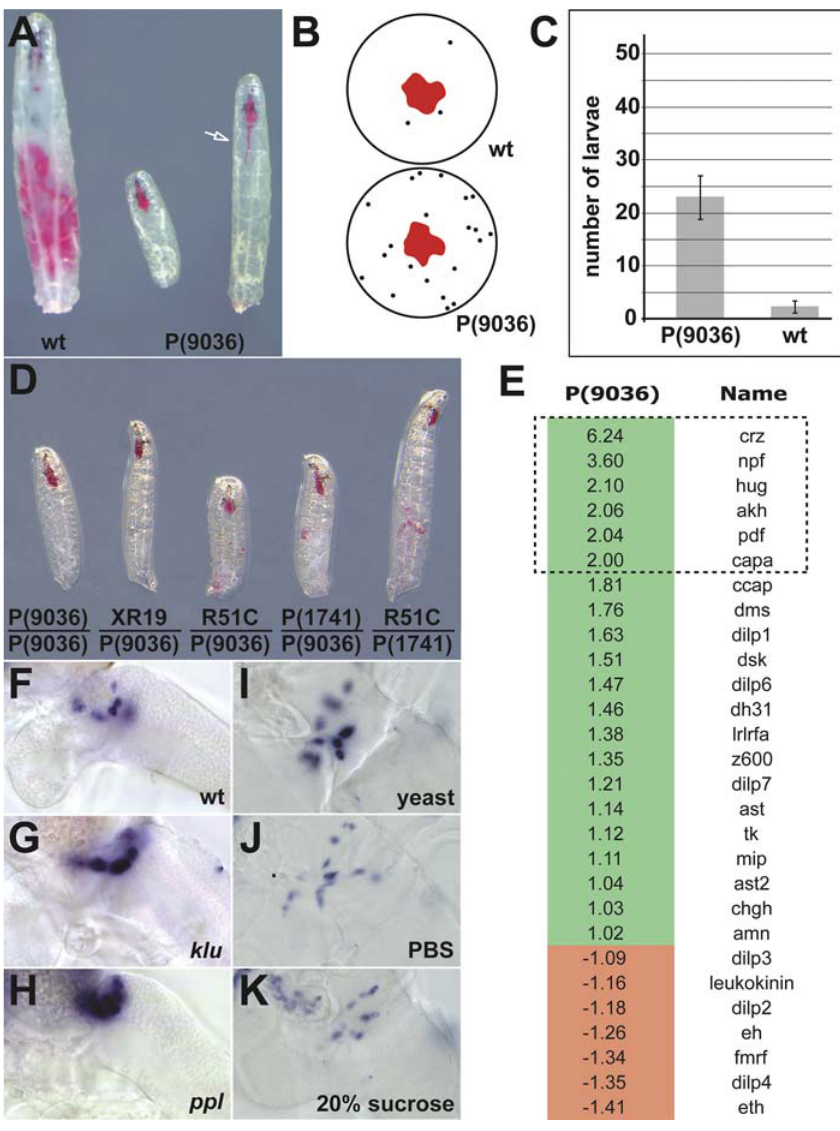
Figure 1. Phenotypic Characterization and Expression Analysis of P(9036) Mutants (A) P(9036)-mutant larvae show feeding and growth defects as compared to wild-type (wt) controls. In wild-type, red food fills the gut, whereas it accumulates in the pharynx of P(9036) mutants. Physically, the food can pass the mutant pharynx (see arrow). (B) P(9036) mutants show a wandering behavior, in which they leave the food source (depicted in a schematic snapshot drawing; dots represent larvae outside the food source, which is shown in red). (C) Quantification of the P(9036) wandering phenotype shows that from 50 individuals, 23 6 4 mutants can be found outside the food source, in contrast to only 2 6 1 for the wild-type control at a given time point ( n ¼ 8 time points). (D) The known klu alleles klu XR19, klu R51C, and P(1741) fail to complement P(9036), and trans-heterozygous larvae display the feeding phenotype. (E) Microarray analysis of P(9036) revealed several neuropeptide genes as being deregulated in P(9036) mutants compared to wild-type controls ( 3 -fold changes in P(9036) are listed; genes with more than 2-fold change are boxed). (F–H) Semi-quantitative in situ hybridizations to first instar larval brains verify the upregulation of the neuropeptide gene hug in P(9036) klu mutants in comparison to wild-type controls, and show an upregulation of hug in ppl feeding mutants as well. The expression of hug is in the SOG. Anterior points to the upper left corner; ventral views are shown. (I–K) Semi-quantitative in situ hybridizations to late second instar larval brains demonstrate a downregulation of hug in wild-type under starvation (PBS) and sugar conditions (20% sucrose), in comparison to normal feeding condition (yeast). Anterior points to the upper left corner; ventral views are shown. DOI: